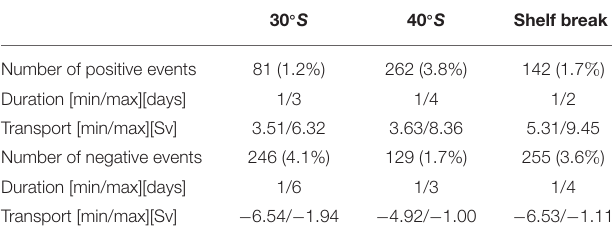
TABLE 4 | Statistics of extreme transport events through selected